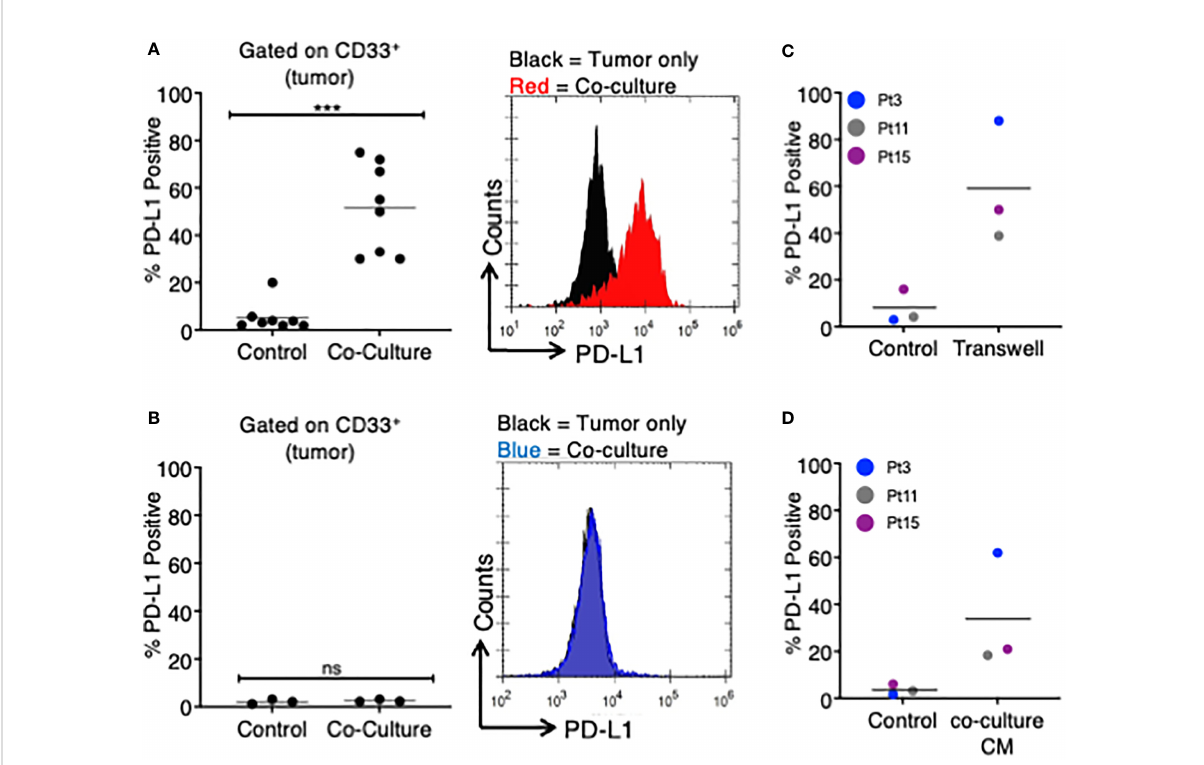
FIGURE 1 MDS cells upregulate PD-L1 in the presence of autologous TA-speci fi c T cells. MDS cells from eight patients were analyzed for PD-L1 expression by fl ow cytometry in various experiments. (A) PD-L1 was measured at baseline (control) or after an 18 – 20-h coculture with autologous tumor-speci fi c T cells (n = 8). A representative histogram plot is shown to the right. (B) A subset of three patients was analyzed for PD-L1 expression at baseline (control) or after an 18 – 20-h coculture with T cells activated with viral antigens (CEF: CMV, EBV, and fl u peptides; coculture). A representative histogram plot is shown to the right. (C) MDS cells from three patients were cultured in a Transwell system (with MDS cells in the lower chamber and MDS:T-cell coculture in the upper chamber), and PD-L1 expression is shown. (D) MDS cells from three patients were analyzed for PD-L1 expression after 18 – 20 h of treatment with coculture conditioned medium (CM) from their respective MDS/ autologous tumor-speci fi c T-cell coculture. ***p < 0.001 by paired t test. ns, not signi fi